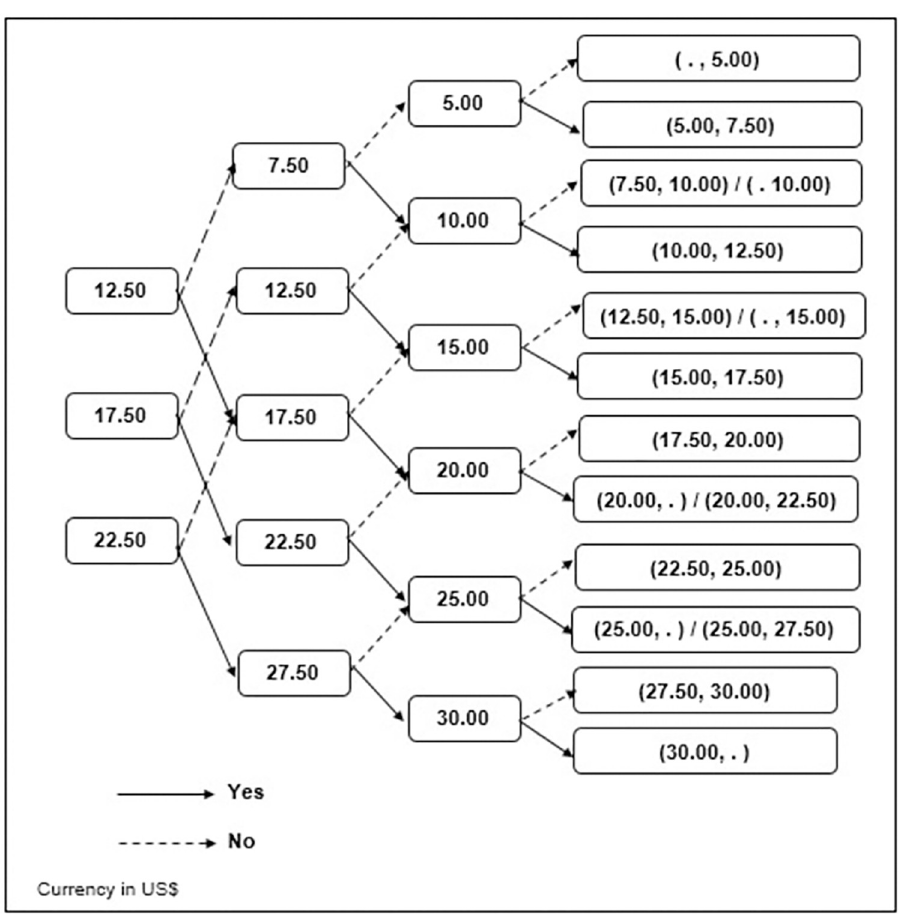
Fig 1. Schematic representation of triple-bounded-dichotomous-choice experiment. � Respondents were asked how much would they be willing to pay in additional taxes per year for any child who needs spectacles to have access to it.